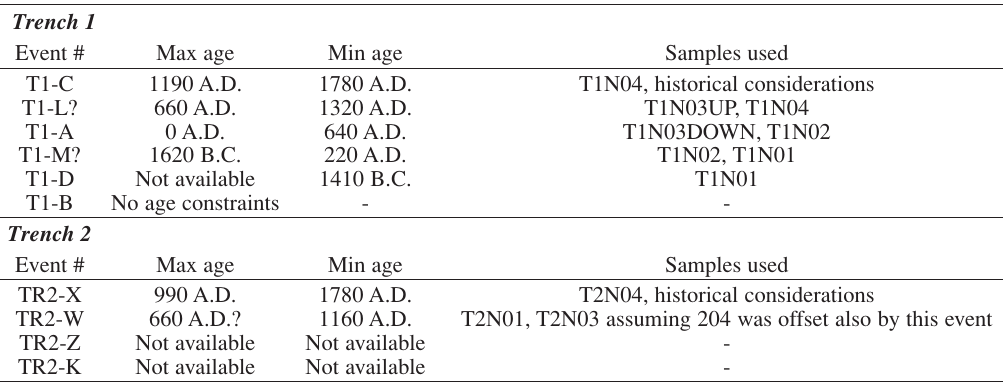
Table II. Ages of paleoearthquakes as constrained in the